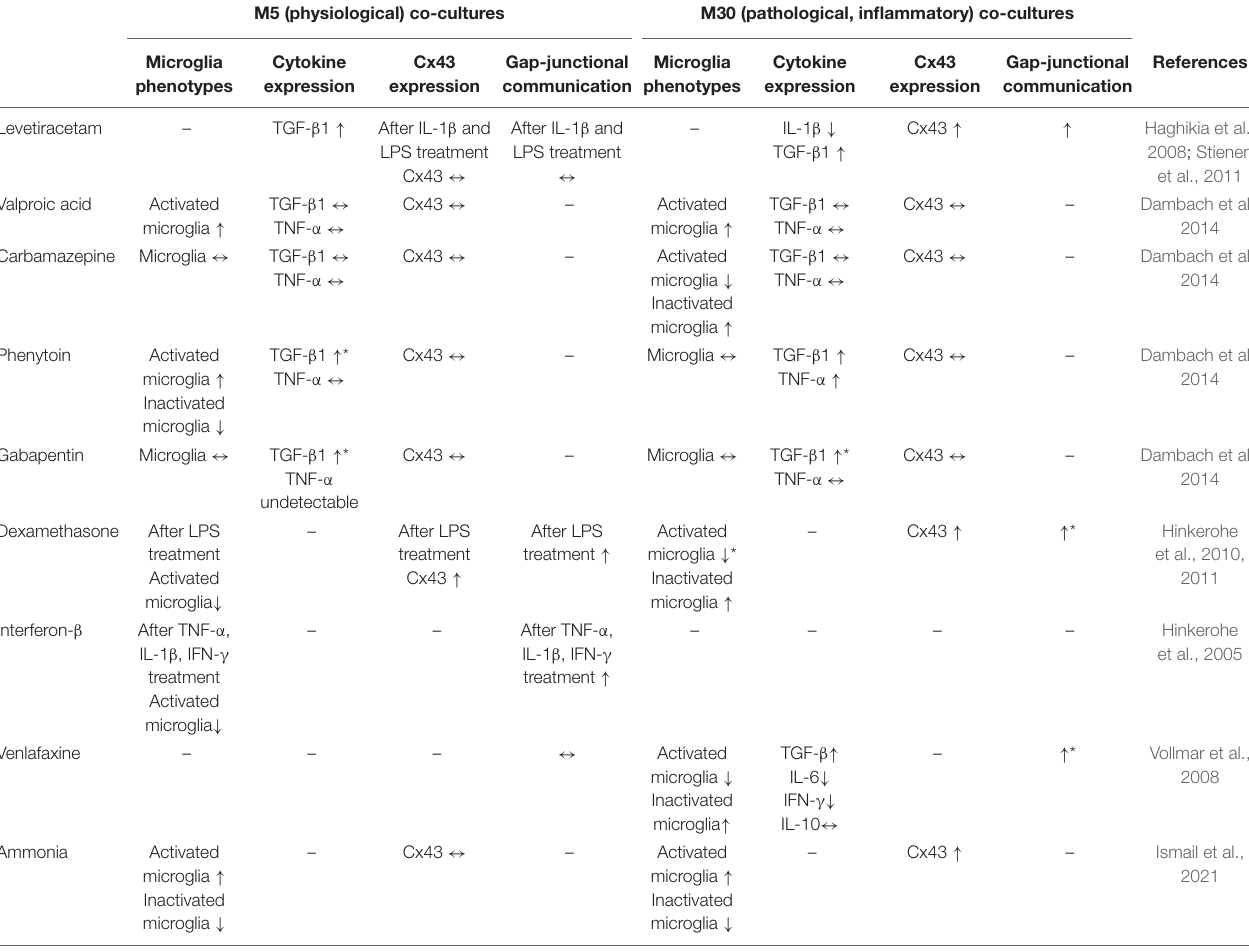
TABLE 1 | Pharmacological investigations in astrocyte-microglia co-culture model of